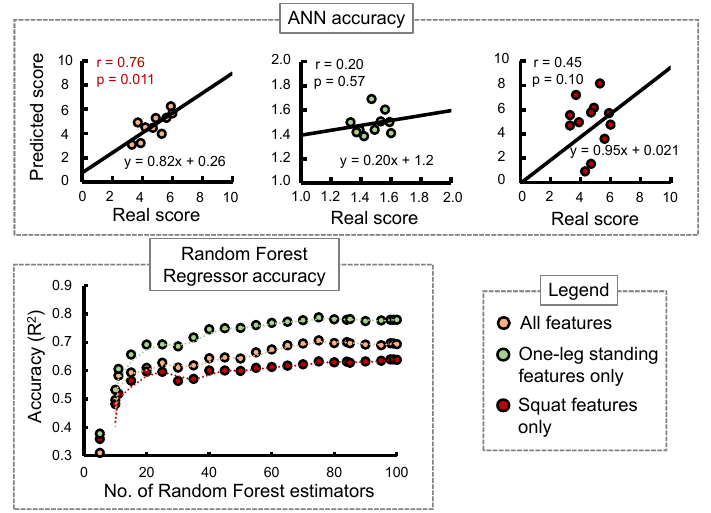
Figure 8. Comparing the accuracy of the ANN and Random Forest regressor in predicting the STBLS test 2-stride score.